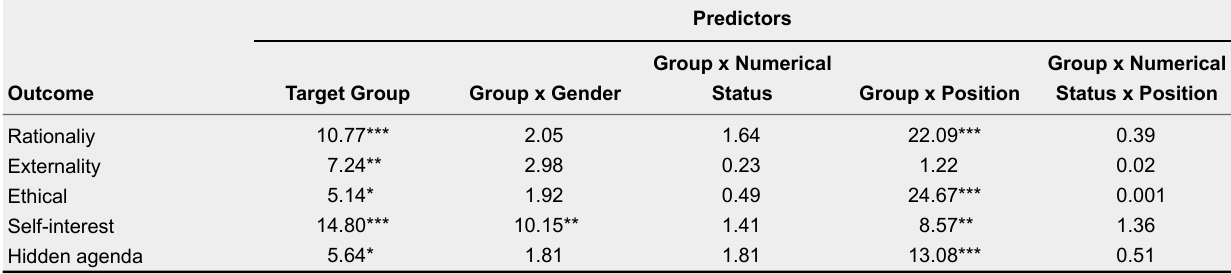
F-Values for All Effects and Dependent Variables (Study 3, N =